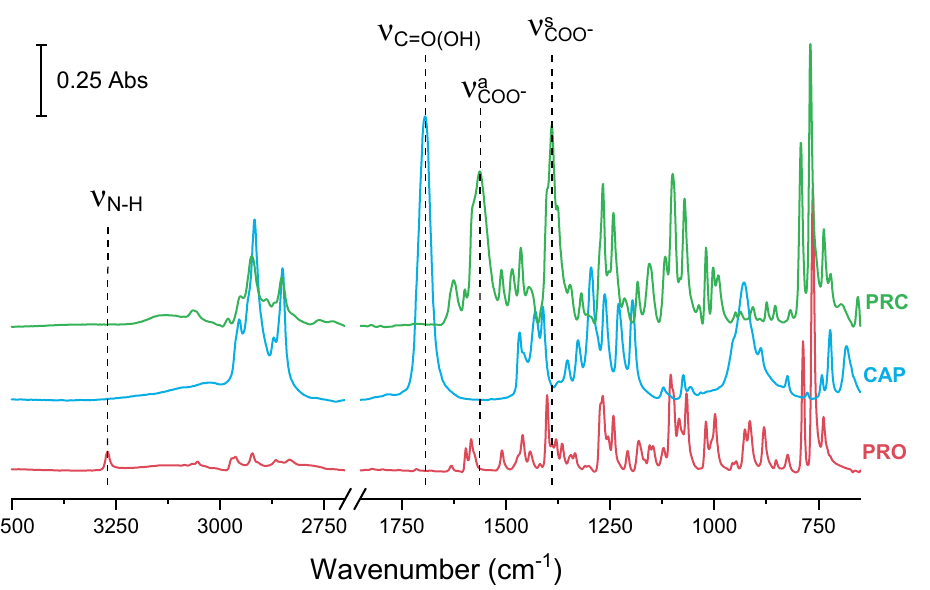
Figure 3. FTIR spectra of PRO, CAP and PRC. ν —stretching vibration, ν s —symmetric vibration, ν a —asymmetric vibration.